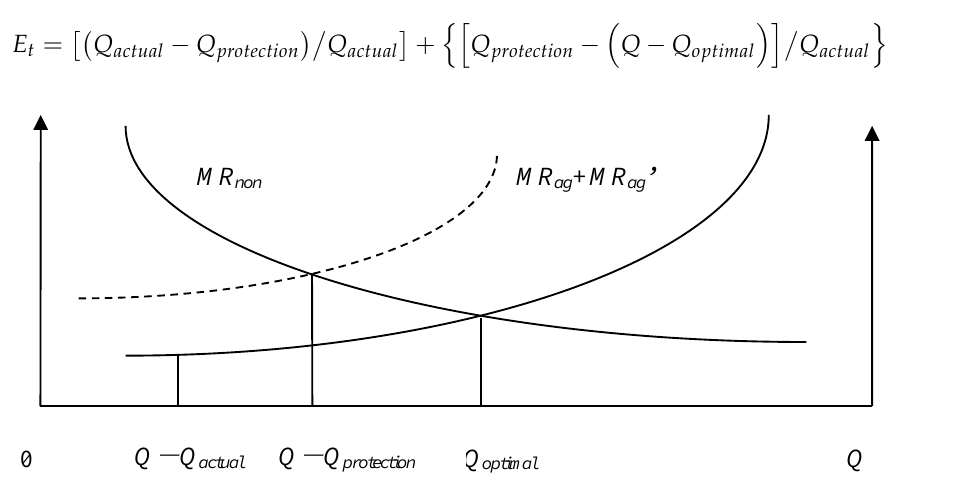
Figure 6. Allocation of county ‐ level land resources under the sixth situation.